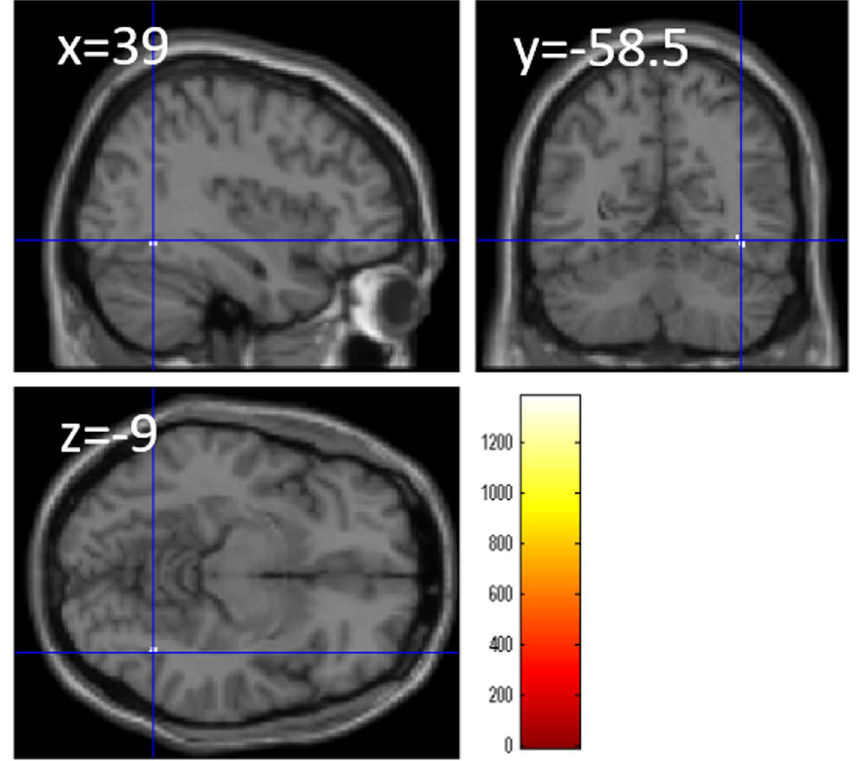
Figure 9. Relationships between the “g-independent” complex processing speed involving spatial cognition and rGMV. Figures represent areas of significant negative correlation between the TBIT spatial relation factor score independent of the general intelligence factor g and rGMV by multiple regression analysis corrected for the effects of age, sex, and general intelligence factor (as calculated from the other CCA tasks excluding Stroop interference). The results shown were obtained using a threshold of TFCE, P < 0.05 corrected (FWE) based on 5000 permutations. In section images, the color bar represents TFCE values. Significant positive correlations were found in the right fusiform